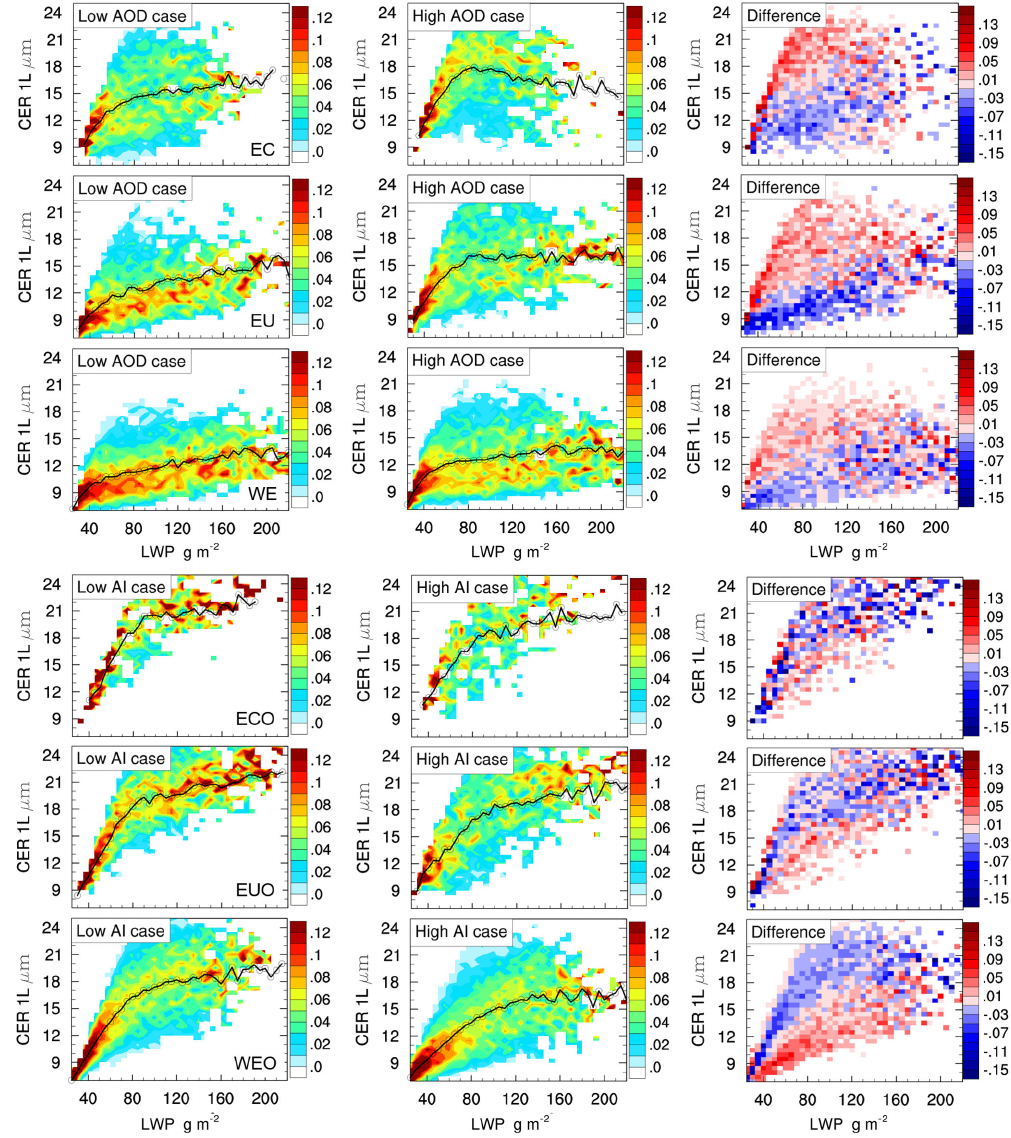
Figure 3. Joint histograms between LWP ( x axis) and CER ( y axis) for EC, EU, WE, ECO, EUO, and WEO. The first and second columns show the LWP–CER joint histograms for the low and high aerosol loading (AOD for land, AI for ocean) cases, respectively. The histograms are normalized so each column sums to 1, such that the histograms show the probability of observing a specific CER, given a certain LWP. The black line indicates the mean CER at each LWP. The third column shows the difference between the polluted and clean